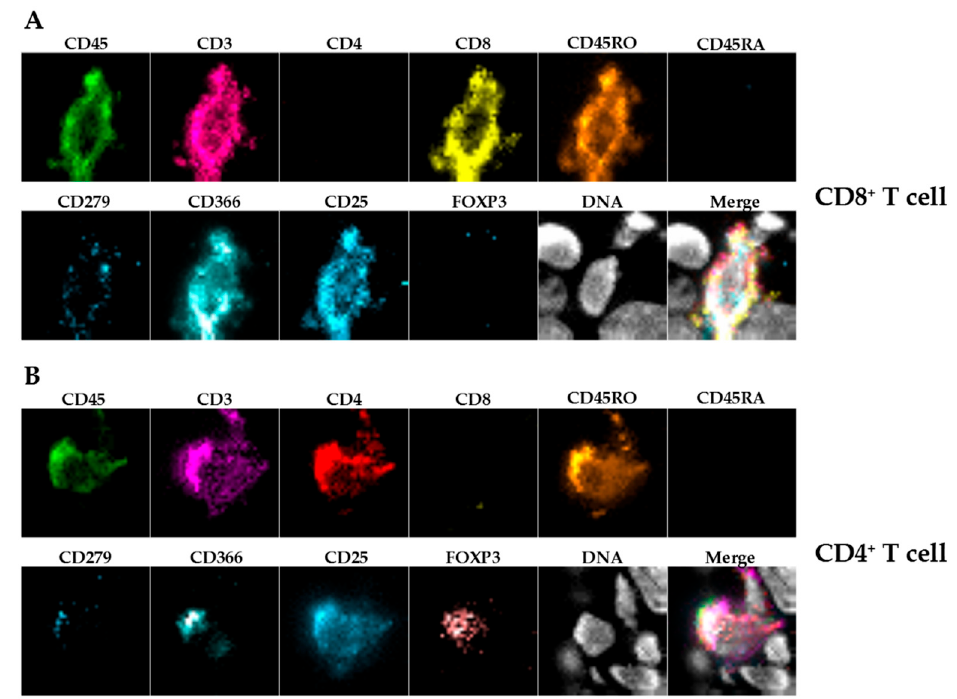
Figure 4. Data comparison of immune cell composition in the tumor microenvironment obtained by Chipcytometry (red), flow cytometry (blue), and immunohistochemistry (grey). Since gating is possible in flow cytometry and Chipcytometry percentages of all cells, respectively, immune cells can be shown ( A , C ), whereas spatial information is only preserved in Chipcytometry and IHC ( B ). Data are shown as box plots with whiskers at min/max. **** p < 0.0001; Statistical significance was determined using the Šídák’s multiple comparison test.